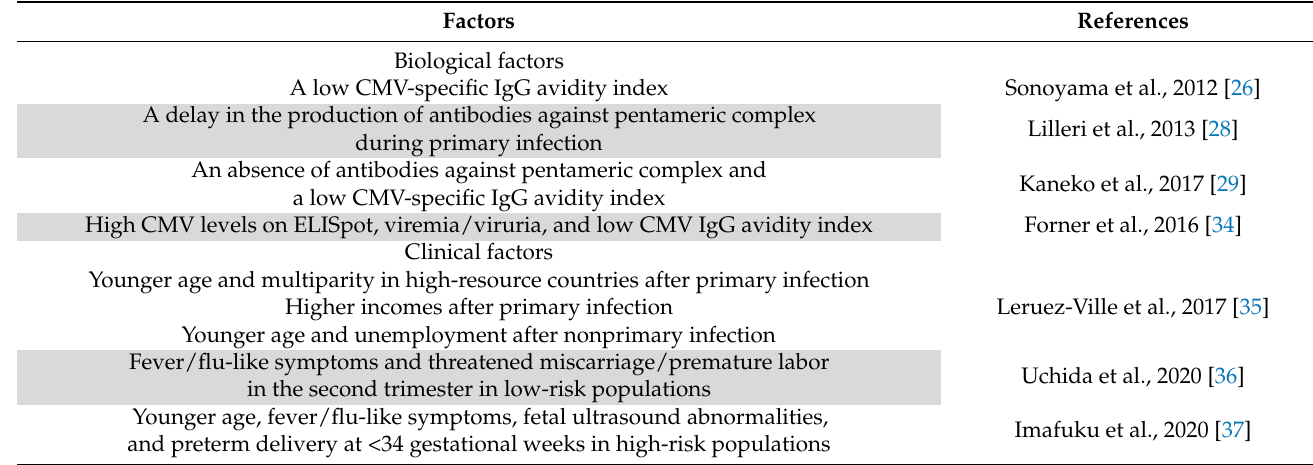
Table 1. Summary of biological and clinical factors associated with increased risk of congenital CMV infection.